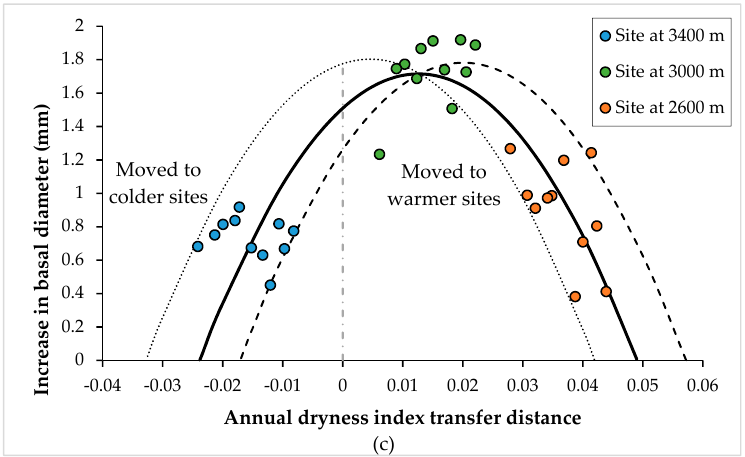
Figure 2. Seedling response to climatic transfer distance for: ( a ) seedling survival; ( b ) aerial biomass (dry weight); and ( c ) increase in basal diameter. Predicted response curves (constructed with the estimated parameters according to the fixed terms of the mixed model, as in Table 4), are indicated for the species (solid line) and for the populations of the coldest site (dashed line) and the warmest site (dotted line). Symbols are observed averages per population per site (the color distinguishes the particular test site). Respective climatic transfer distance on the x -axis signifies the transfer to drier and/or warmer sites if the values are positive, and transfer to cooler and/or moister sites if they are negative. Zero signifies a climate similar to that of the site of provenance.